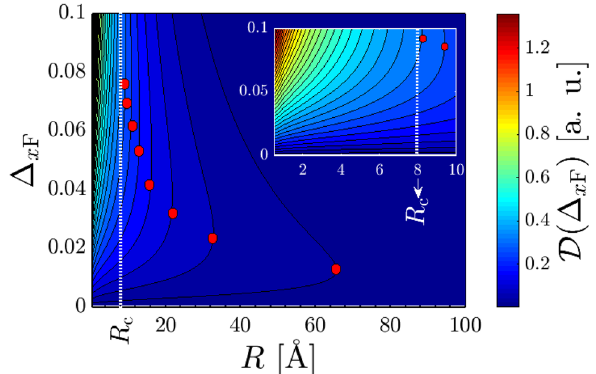
(cid:31) x F as a function of ferroelectric distortion = 0 . The critical gap for which D (� 0 at (cid:31) y F = x F ) turns to the increasing =